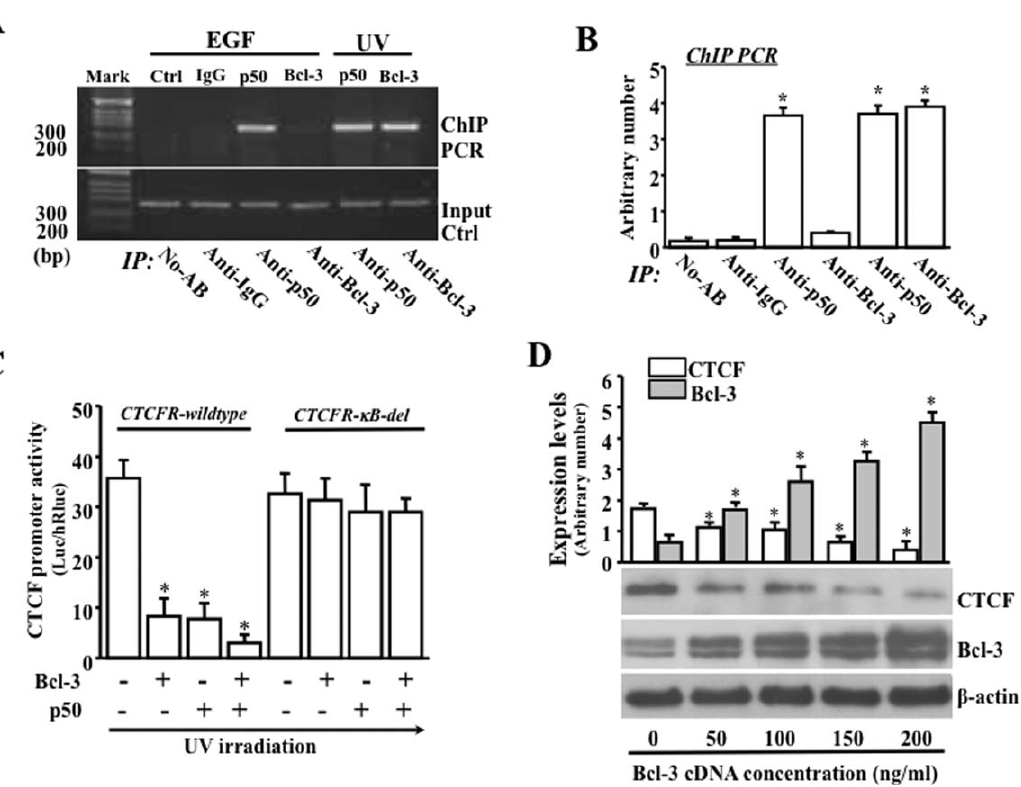
Figure 3. Interaction of Bcl-3 and p50 with CTCF promoter. (A) EGF- and UV stress-induced interactions of Bcl-3 and p50 with CTCF promoter detected by ChIP assays. (B) Analysis of interactions between Bcl-3/p50 and CTCF promoter. (C) Effect of over-expression of Bcl-3 and p50 on activities of wildtype and deletion mutant of CTCF promoter. (D) Dose-response relationship between over-expression of Bcl-3 and suppression of CTCF expression. HCE cells were transfected with full-length cDNAs encoding Bcl-3 (a generous gift from Dr. Shin-Ichiro Takahashi at the University of Tokyo) and p50, CTCF reporter and the mutant CTCF reporter with k B site-deletion by lipofection. Symbol ‘‘*’’ indicates significant differences between control and transfected cells ( p , 0.05,